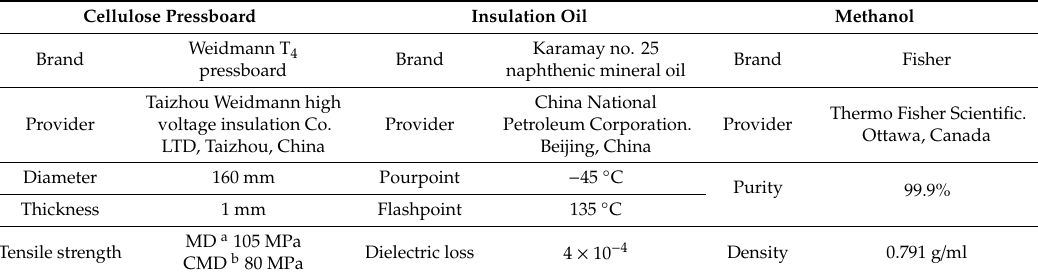
Table 1. Parameters of the materials.